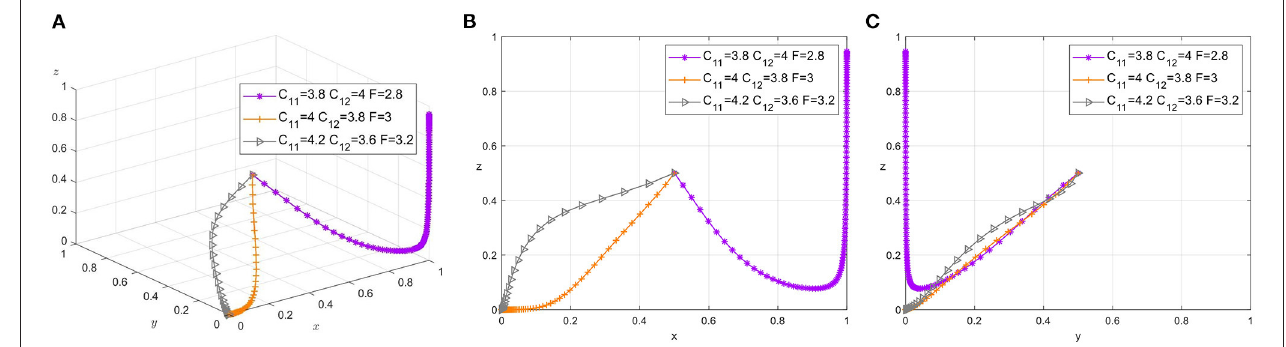
FIGURE 3 | (A) Tripartite strategy evolution. (B) Safety managers-workers. (C) Foremen-workers.